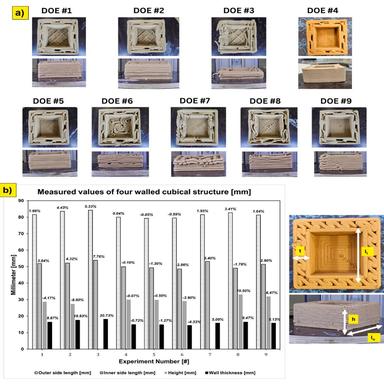
(a) Top and side elevation of 3DP structure (b) Bar chart depicting dimensional accuracy of 3DP structures.